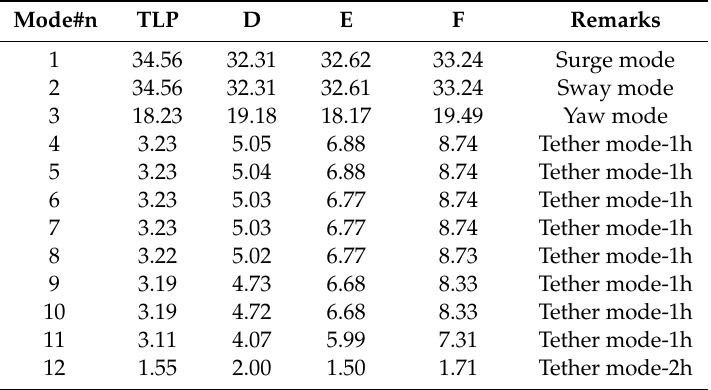
Table 5. Natural periods of the TLP type wind turbine.